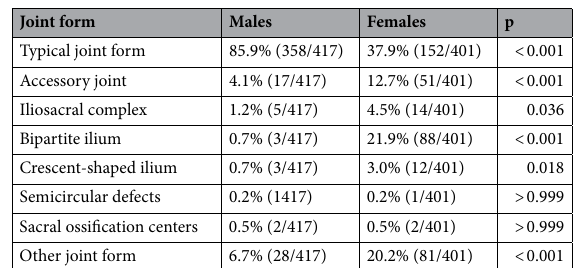
Table 3. Frequencies of joint forms. P-values derived from Chi 2 tests.